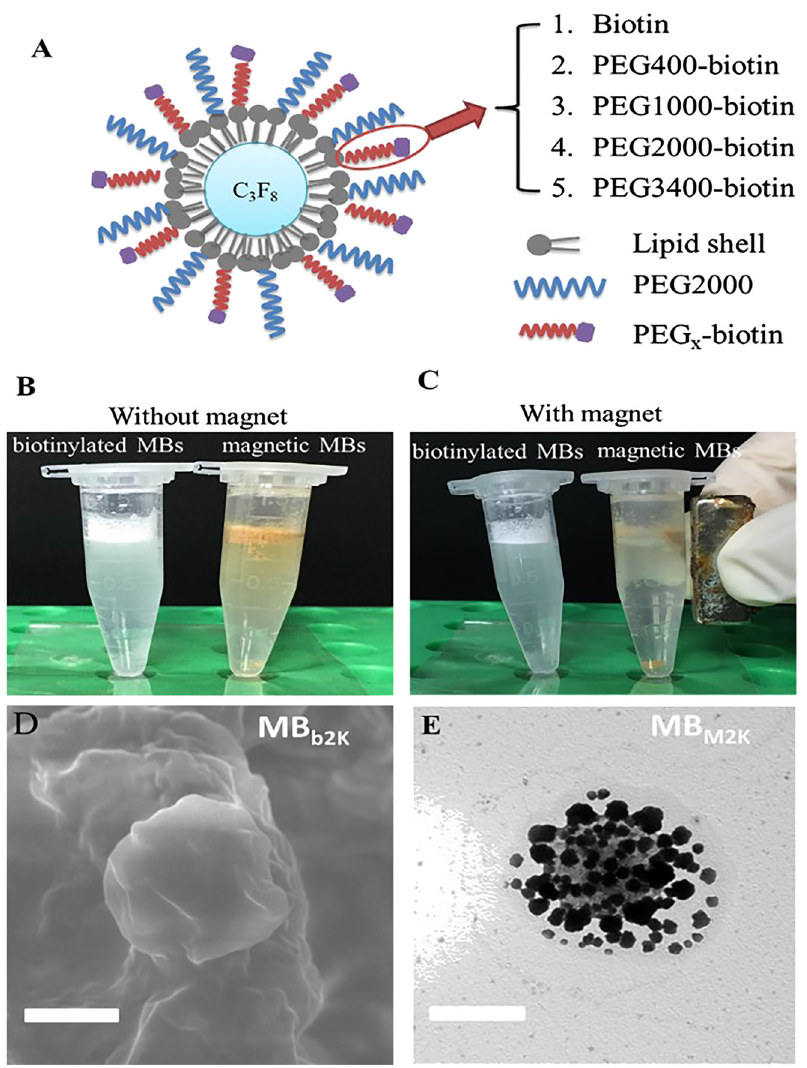
Figure 2: (A) Illustration of the synthesized five types of biotinylated microbubbles (MBs) with different connecting polyethylene glycol (PEG) chain lengths (none, PEG400, PEG1000, PEG2000, and PEG3400)tocombinewithmagneticNPsfor magnetic MBs formation. (B) Optical images of the as prepared biotinylated MBs and magnetic MBs without a magnet and (C) with a magnet placed near them. (D) The scanning electron microscope (SEM) micrograph of biotinylated MBs and (E) the TEM micrographs of magnetic MBs. The scale bar is 2 μ